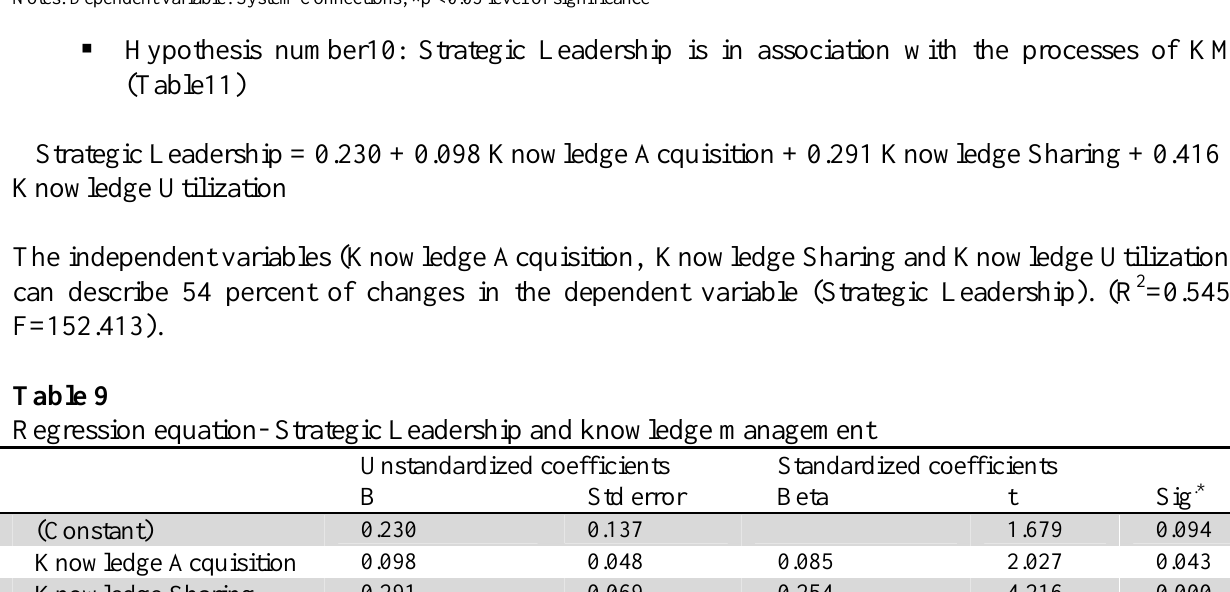
The independent variables (Knowledge Acquisition, Knowledge Sharing and Knowledge Utilization)